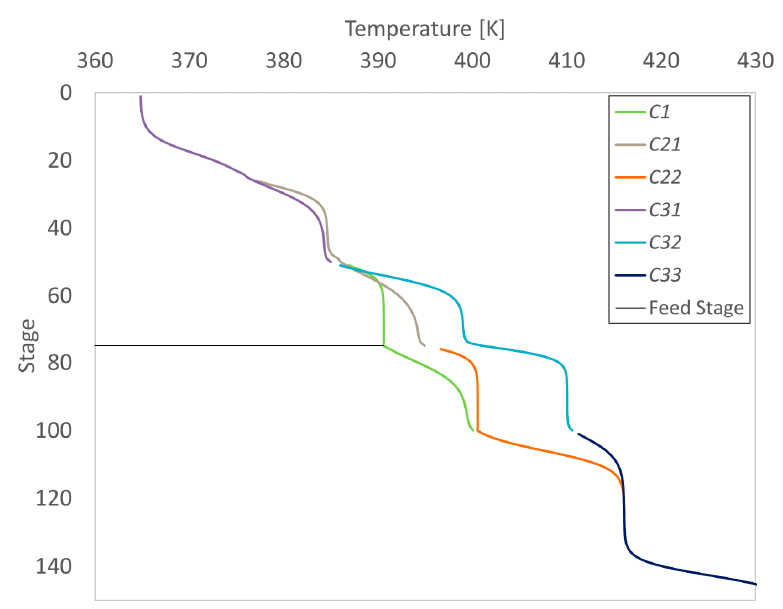
Figure 11. Temperature profile of the separation of 3-Metylhexane/Toluene/Ethylbenzene/1-Methyl-3-Ethylbenzene in a conventional mDWC.